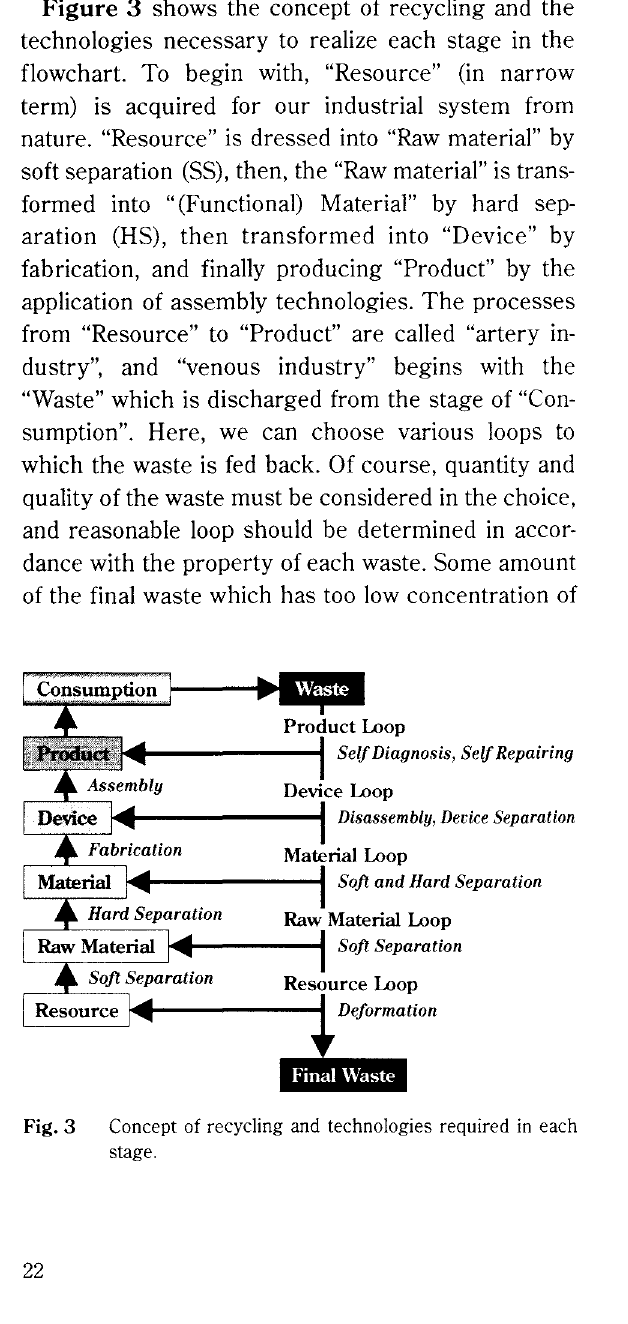
Concept of recycling and technologies required in each